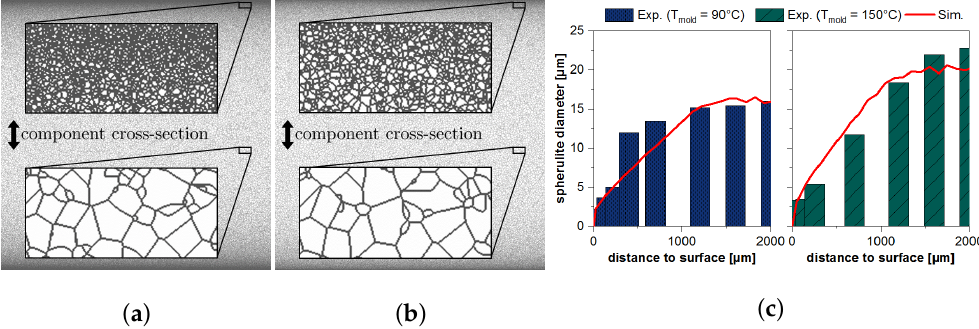
Figure 8. Simulated spherulitic microstructure of PBT after cooling at a mold temperature of ( a ) 90 ◦ C and ( b ) 150 ◦ C. ( c ) Comparison of the mean diameters of the spherulites determined by experiment and